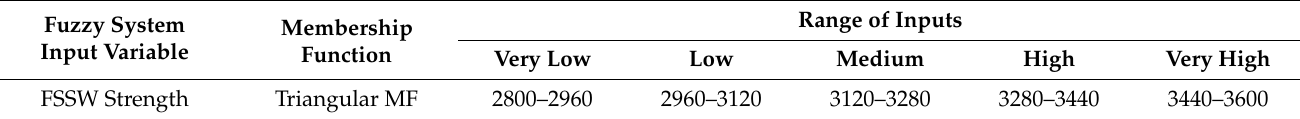
Figure 17. Defuzzification step in FSSW strength (dynamic parameters) fuzzy system.